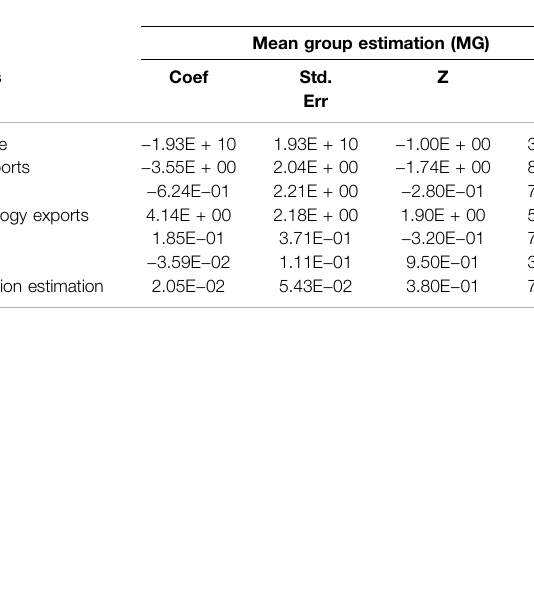
TABLE 5 | Panel Data Analysis using MG, DFE, and PMG for Latin American